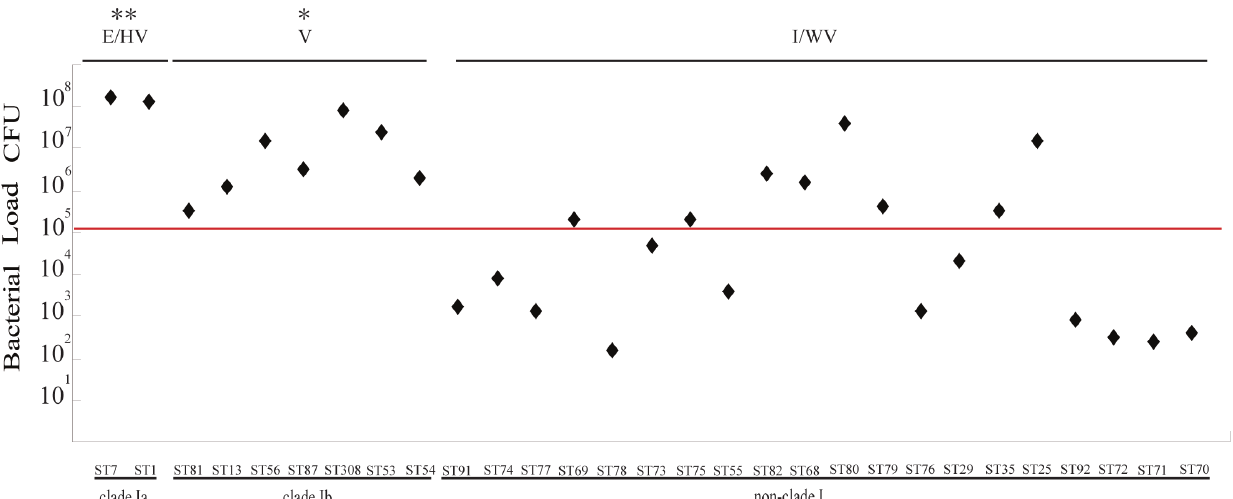
Figure 2. Blood bacterial load of the test strains in the infected mice. All data are from two independent experiments. E/HV: epidemic or highly virulent group, V: virulent group, I/WV: intermediately or weakly virulent group. *Significant, P , 0.05, two asterisks (**): the value of group E/HV compared to group V and I/WV. One asterisk (*): the value of group V compared to group I/WV.